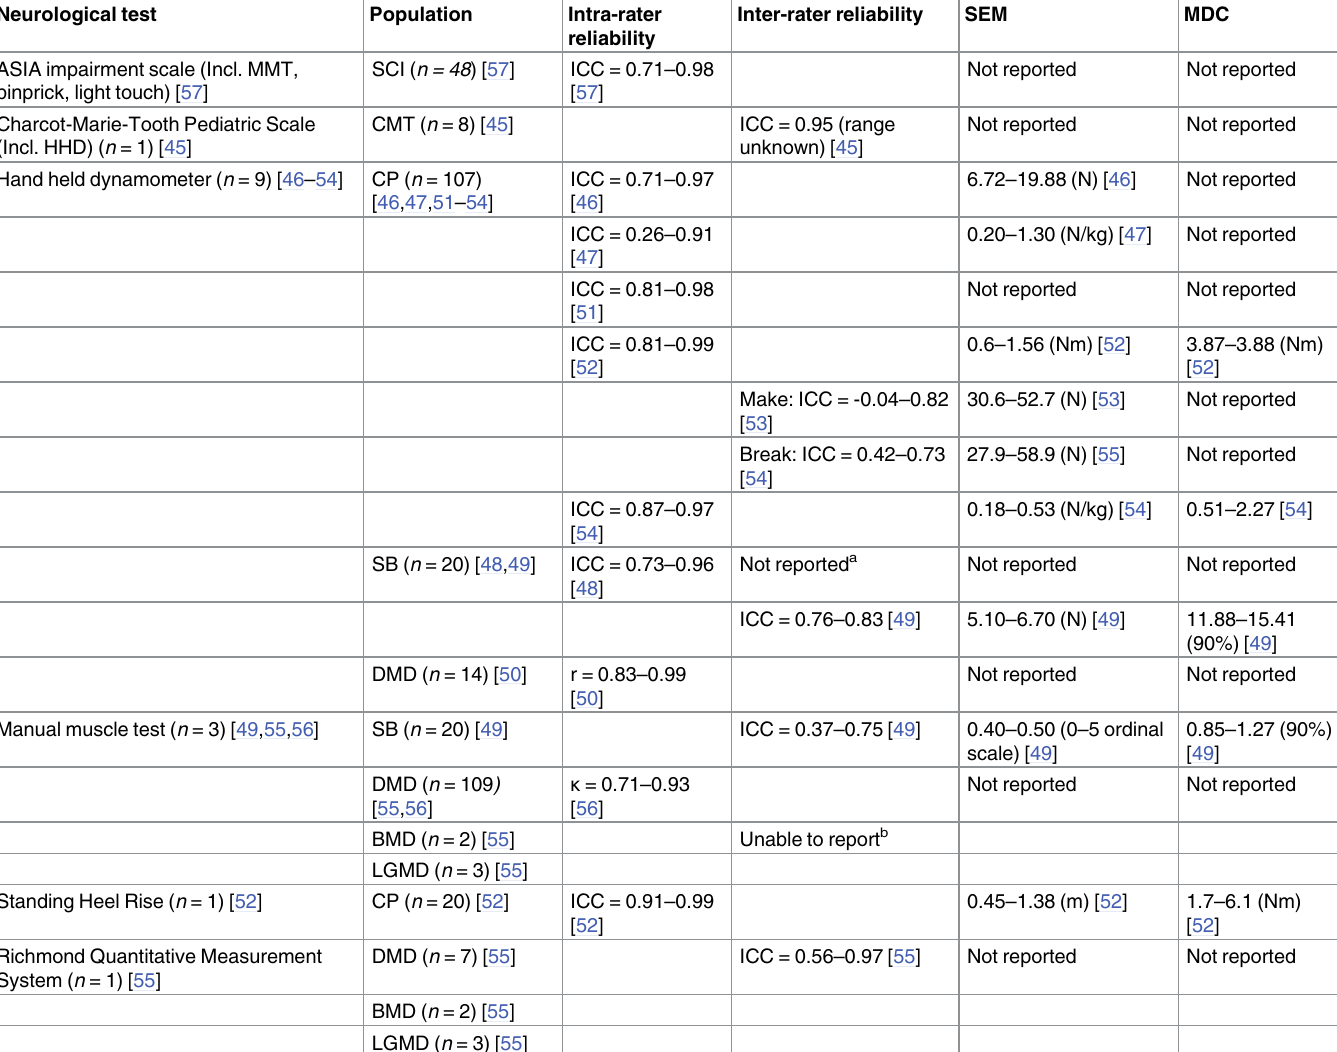
Table 5. The clinimetric properties of neurological tests for children and young people with a neurological condition. Neurological test Population Intra-rater